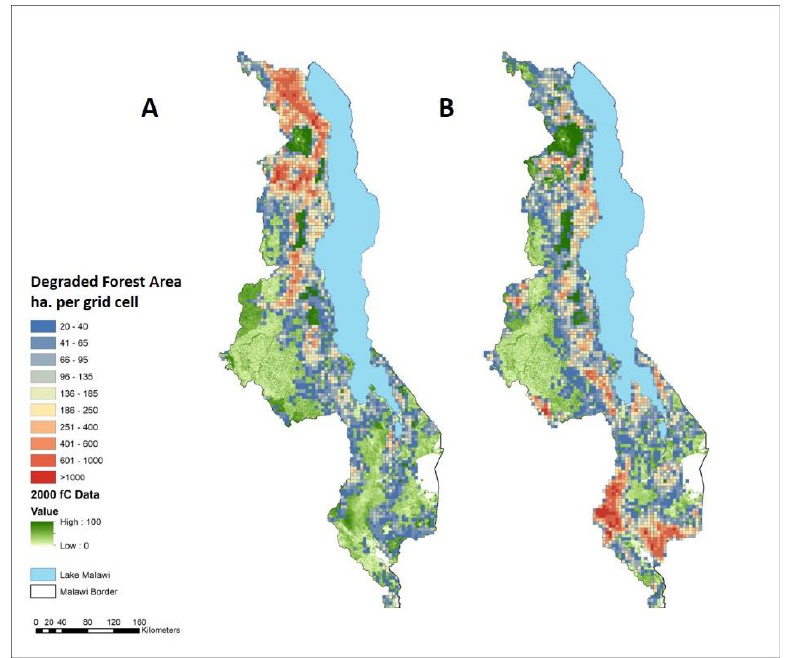
Figure 6. Mapped areas of forest degradation, 2000–2009 ( A ), 2010–2015 ( B ), as the area of total new degraded forest (ha) created during each period within each 25 km2 grid cell. Cells where degraded area is <20 ha are not shown.